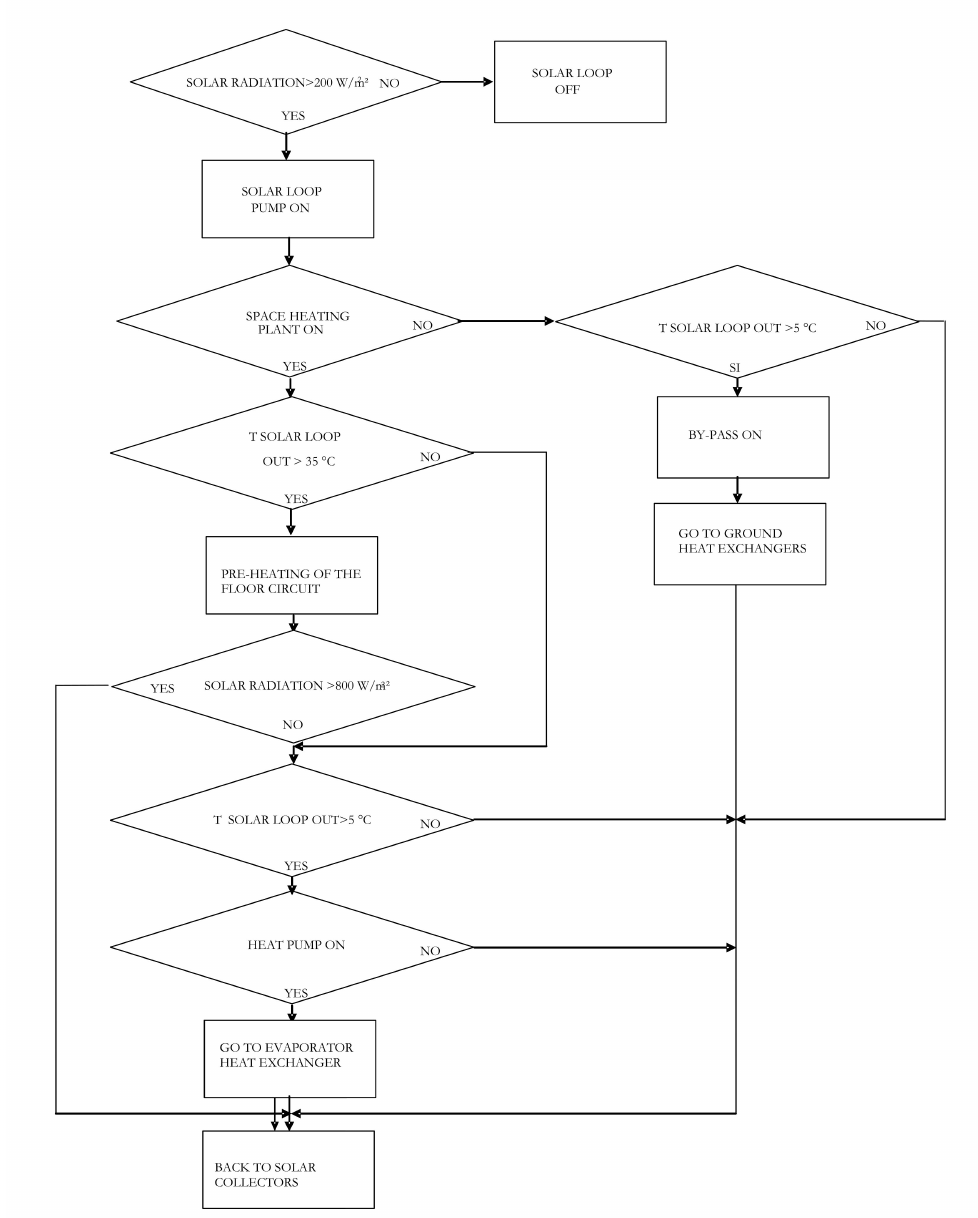
Figure 3. Flow diagram of the space heating control system.